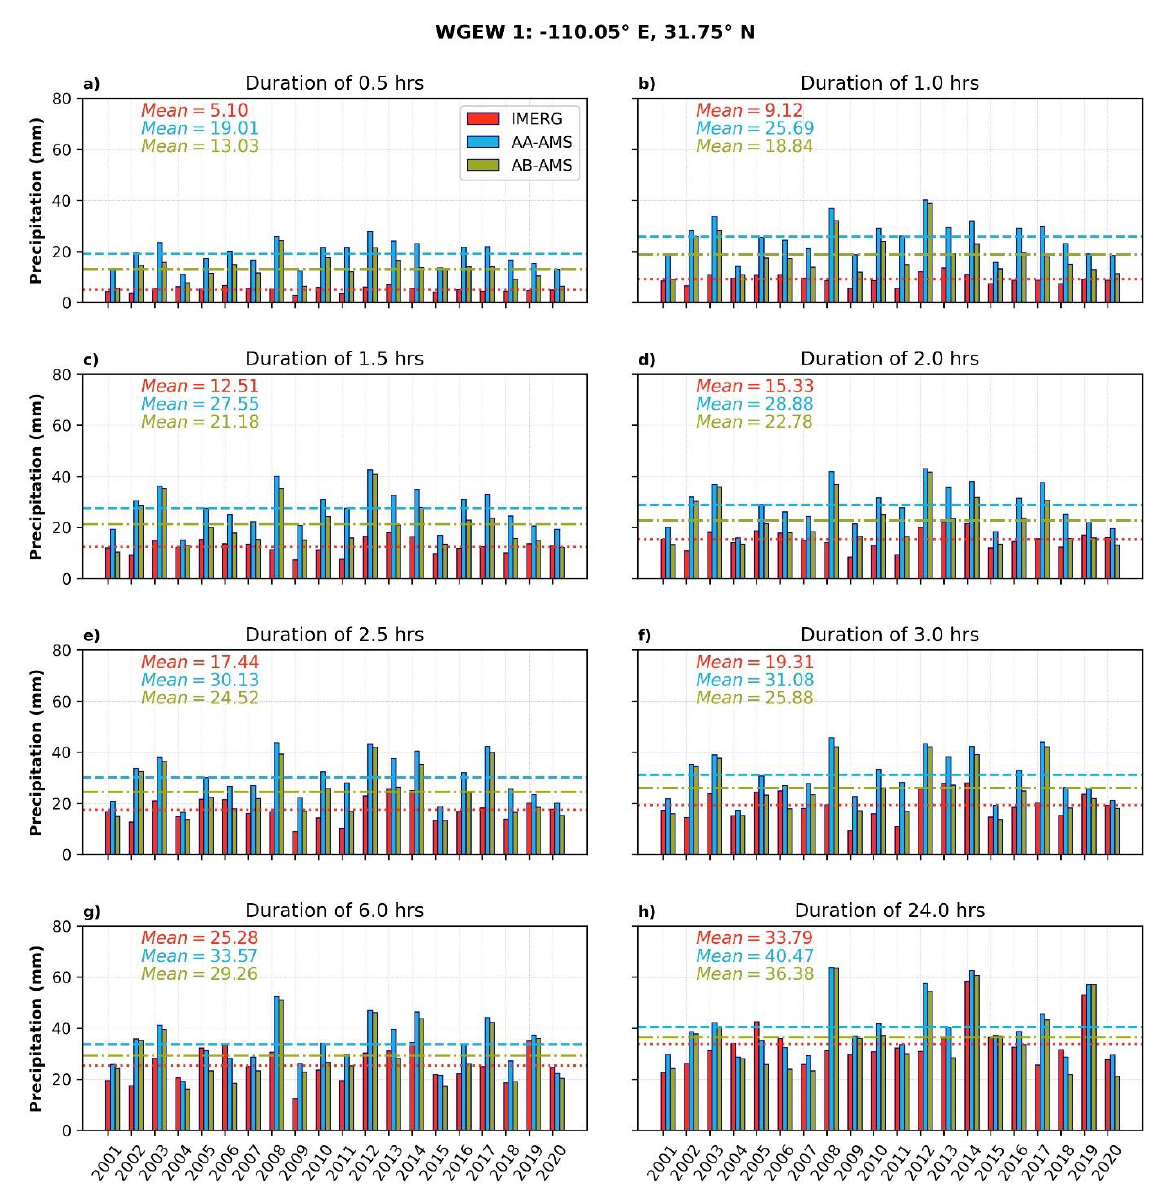
Figure 4. Annual maximum time series for WGEW 1 by durations. The subfigures illustrate event durations of 0.5-h ( a ), 1-h ( b ), 1.5-h ( c ), 2-h ( d ), 2.5-h ( e ), 3-h ( f ), 6-h ( g ), 24-h ( h ). In all the subfigures, the red bars are the IMERG AMS, light blue bars are the AA-AMS, and the green bars are the AB-AMS. The dashed lines are the mean AMS for each case.